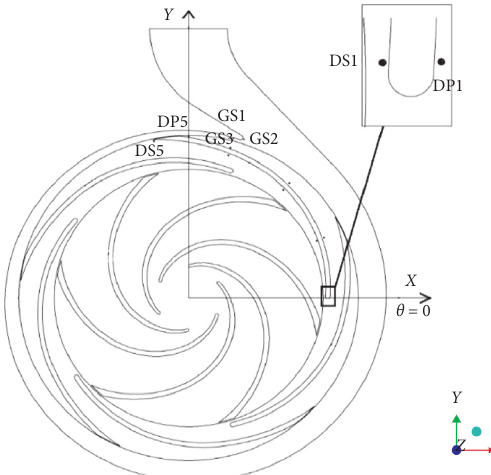
Figure 11: Monitoring points of the centrifugal pump.